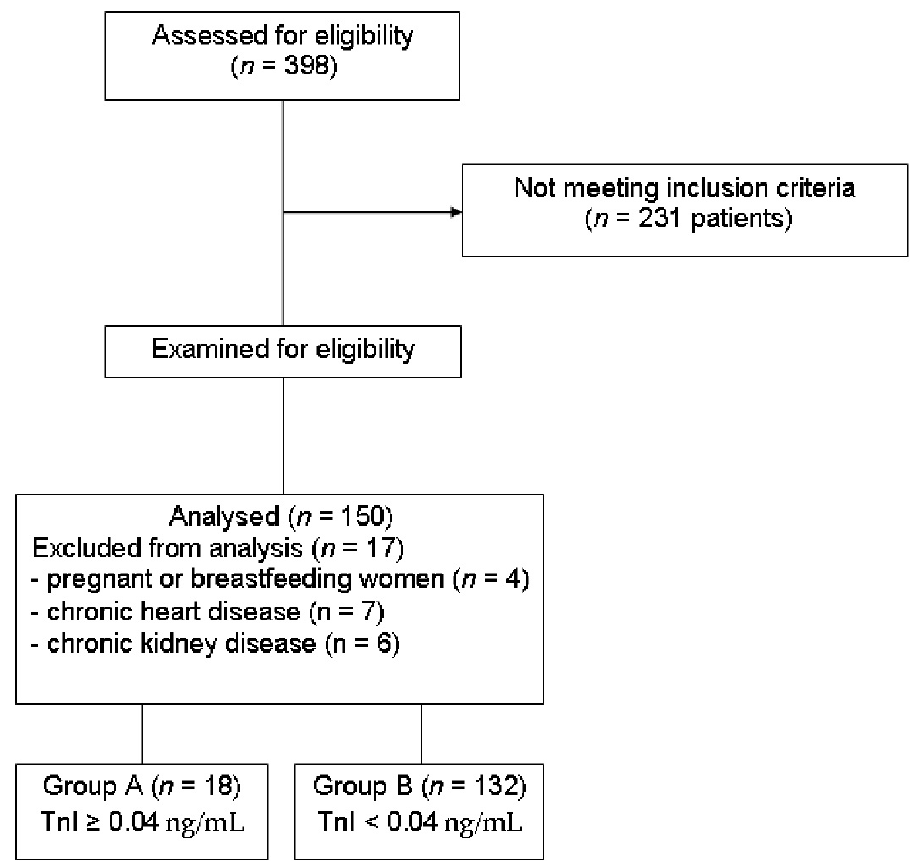
Figure 1. The flow diagram of the study describing recruitment, inclusions and exclusions in the study. Abbreviations: TnI-troponin I.